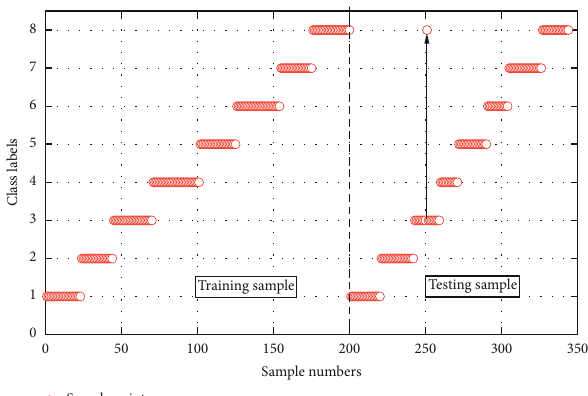
Figure 9: Gearbox fault identification and classification result of the method proposed in this